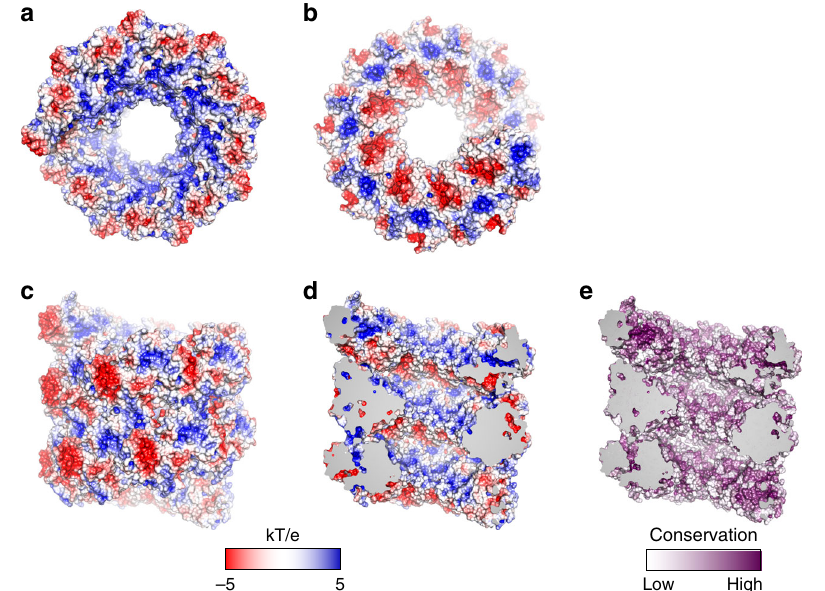
Fig. 2 Electrostatic surface potential and conservation analysis of the TorsinA fi lament. a , b Top- and bottom-end electrostatic surface views of the TorsinA fi lament, revealing a basic character in ( a ) and an acidic character in ( b ) in tube interior. c Exterior electrostatic surface view of the TorsinA fi laments. d A cutaway electrostatic surface view of the TorsinA helical tube, revealing an undulating pattern of positive and negative charges on the interior surface of the helical tube. e Surface conservation of TorsinA. Same view as ( d ). Basic residues on the interior surface of the helical tube are mostly conserved